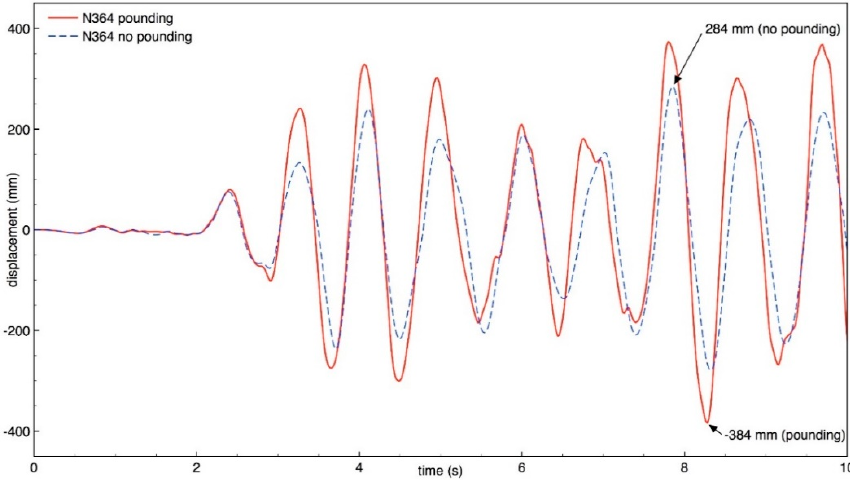
Figure 11. Longitudinal response of building A (node N364) with and without pounding.